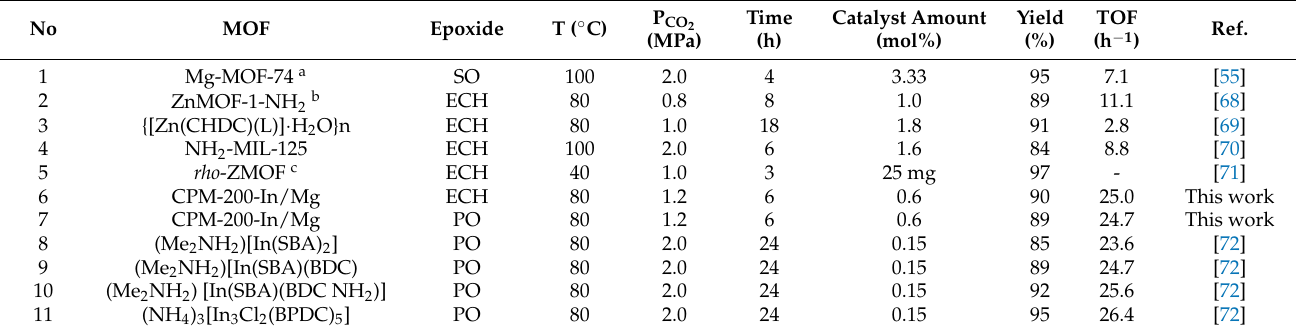
Table 5. Comparison of the catalytic potential of the CPM-200-In/Mg with previously reported MOFs.